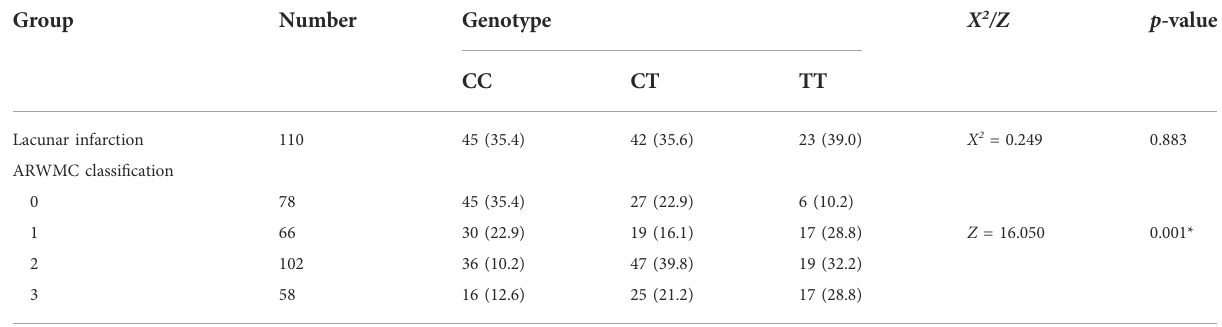
TABLE 2 Relationships between MTHFR genotype and cerebrovascular lesions [n(%)]. Group